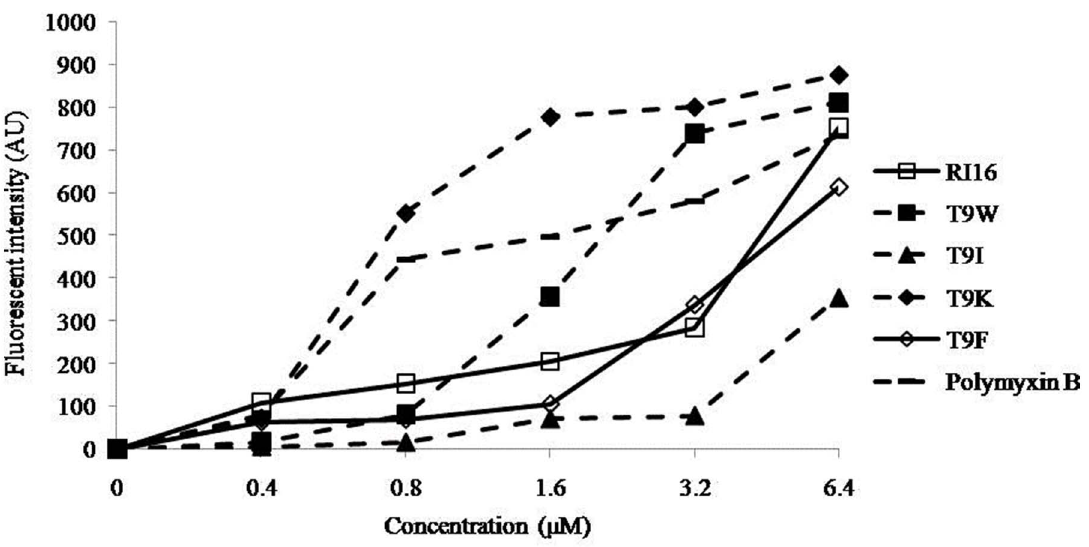
Fig. 3. The outer membrane permeability of the peptides. The uptake of NPN of P. aeruginosa 27853 in the presence of different concentrations of the peptides determined using the fluorescent dye (NPN) assay. The NPN uptake was monitored at an excitation wavelength of 350 nm and an emission wavelength of 420 nm.